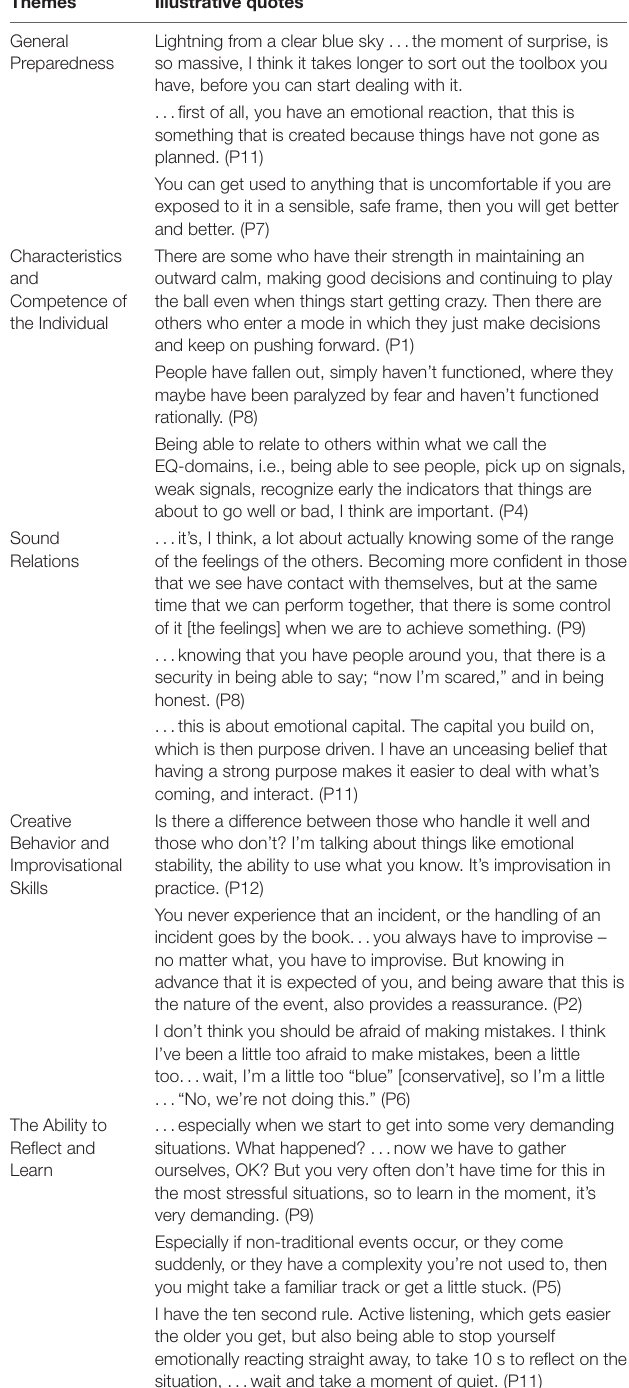
TABLE 7 | Quotes illustrating the role of emotions across the other main types of